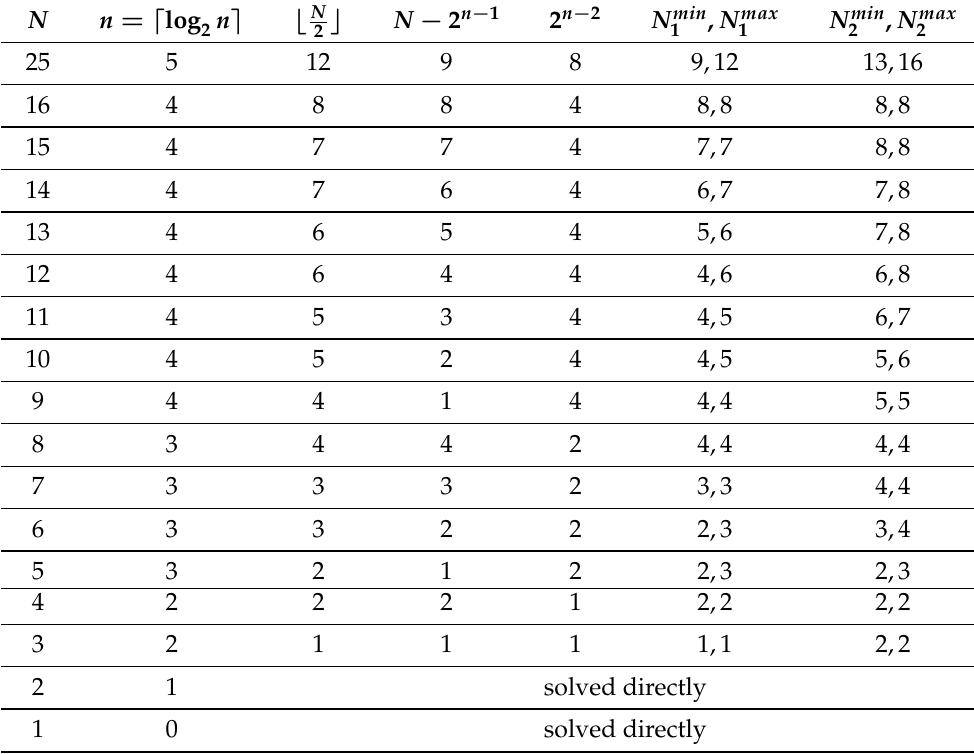
Table 3. Games playing stages for each tournament and tournament